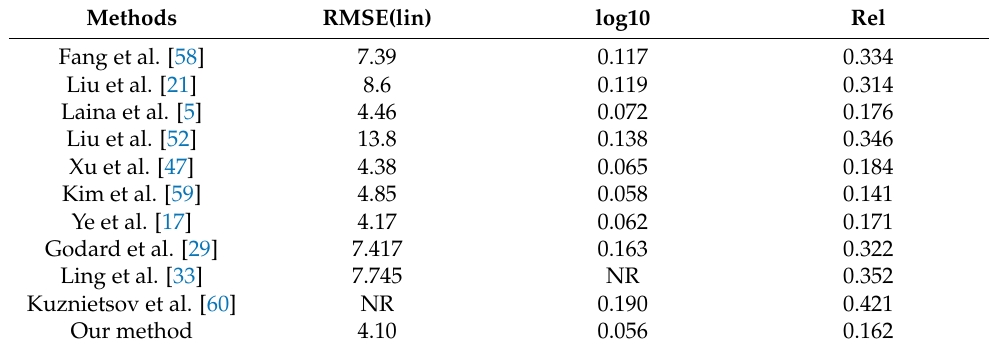
Table 3. Quantitative comparison results on Make3Ddataset.